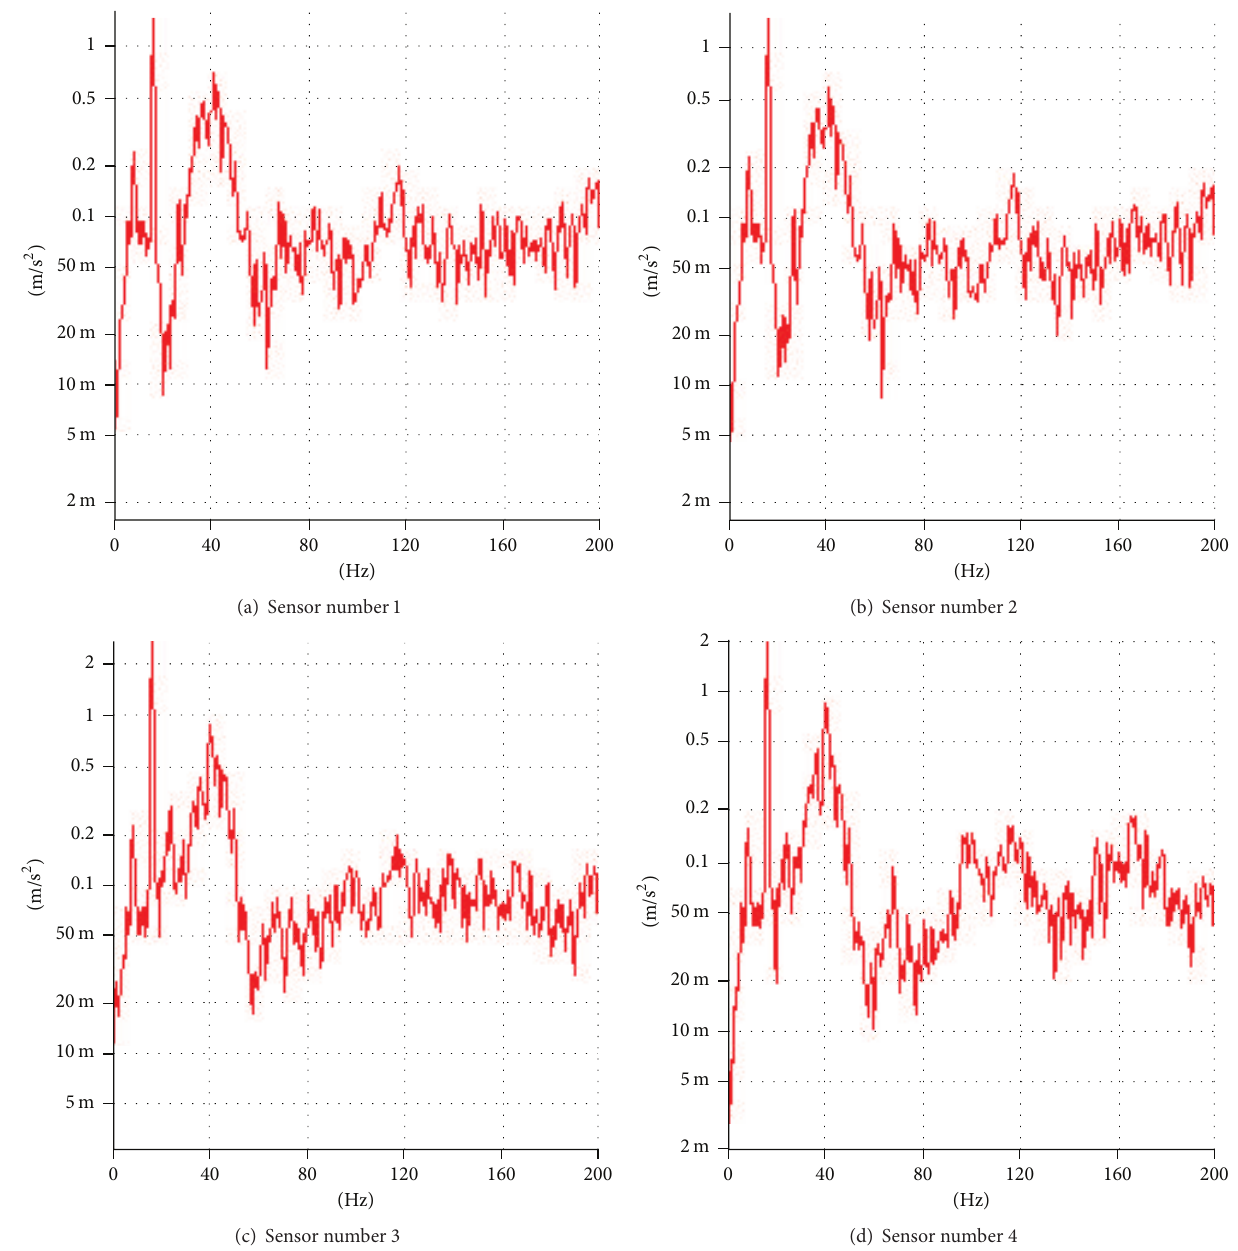
Figure 8: Dynamic frequency